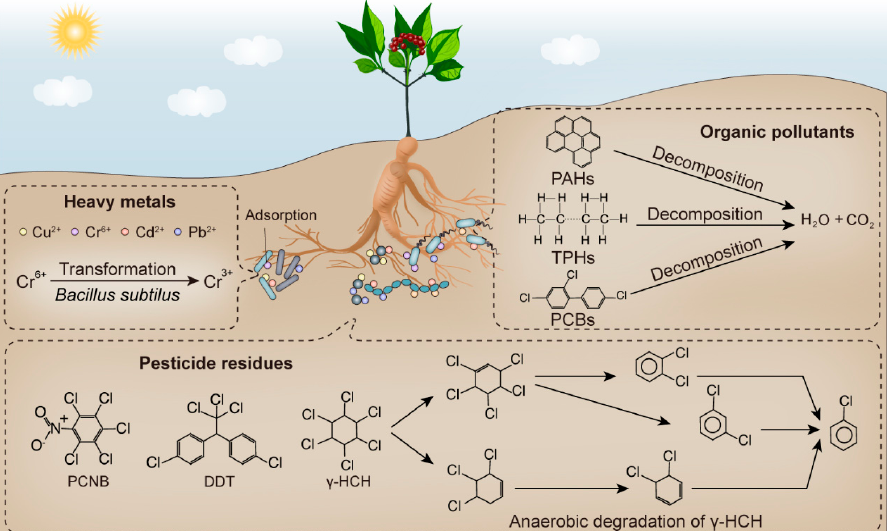
Figure 3. Removal of soil contaminants (pesticide residues, heavy metals and organic pollutants) by microorganisms and the potential mechanism. Heavy metals are adsorbed and fixed on the cell surface by microorganisms. Highly toxic metallic elements can be converted to less or non-toxic substances by redox reactions. The chemical pesticides and organic pollutants are broken down by soil microbes into small molecule compounds, H 2 O and CO 2 .